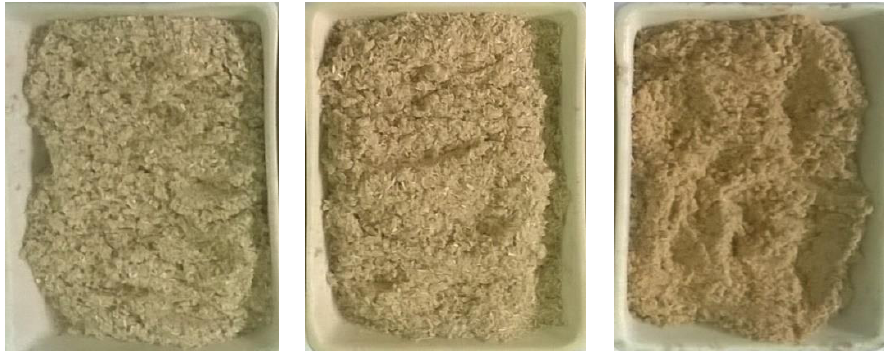
Figure 3. Samples ready for densification: from left to right, the samples of the raw material dried at 60, 100, and 140 °C, respectively, in the dry state are shown.